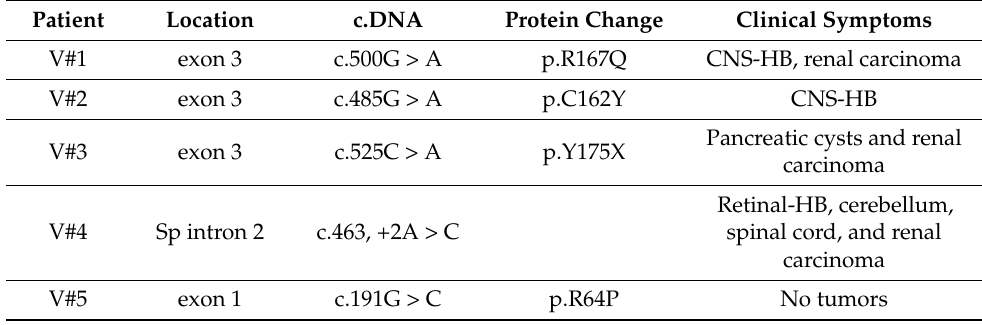
Table 2. Genotypes and phenotypes of the VHL